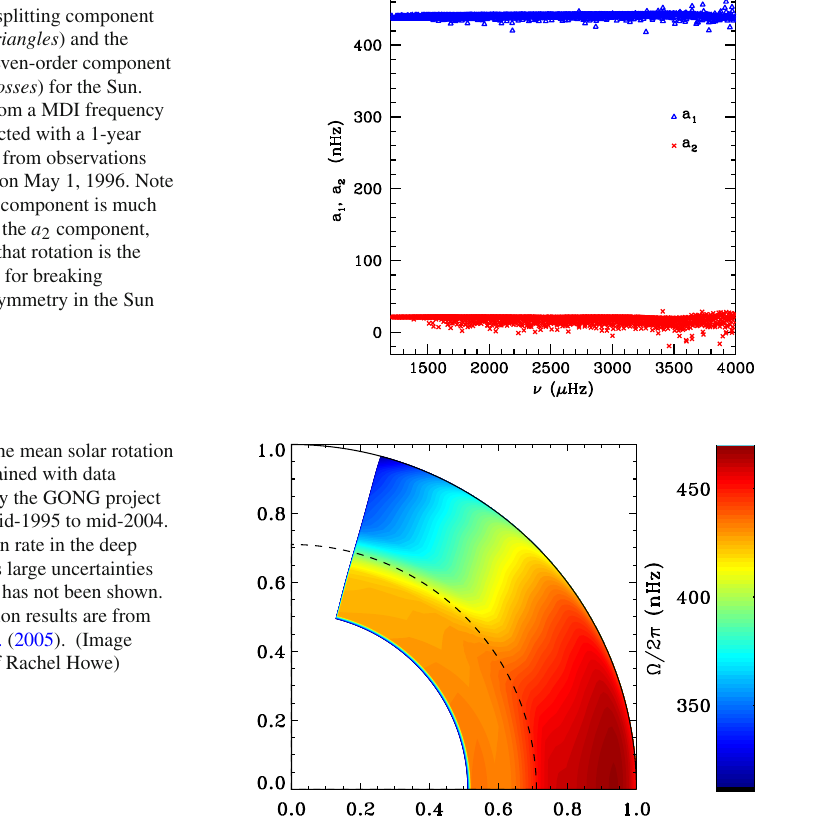
Fig. 25 The dominant odd-order splitting component ( a 1 ; blue triangles ) and the dominant even-order component ( a 2 ; red crosses ) for the Sun. Data are from a MDI frequency set constructed with a 1-year time series from observations that began on May 1, 1996. Note that the a 1 component is much larger than the a 2 component, indicating that rotation is the main agent for breaking spherical symmetry in the Sun